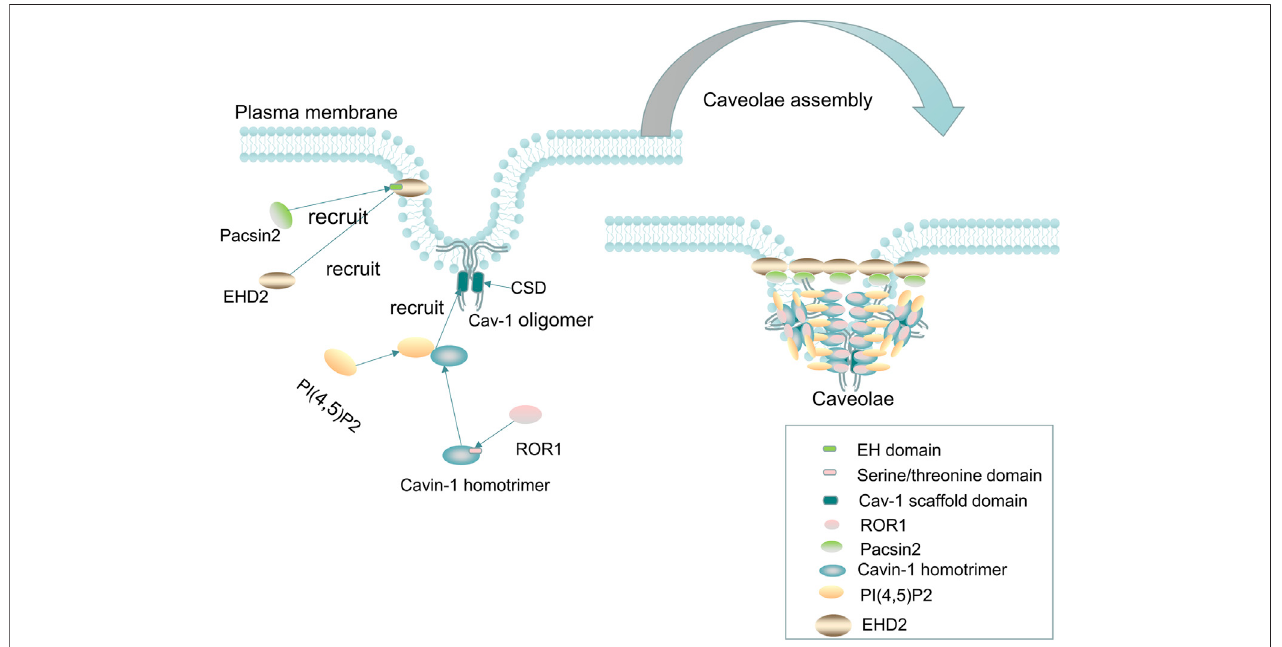
FIGURE 1 | Cav-1 and caveolae. Cav-1 is essential for the formation of caveolae. The cholesterol-containing scaffold protein domain (CSD) of Cav-1 binds to cholesterol on the plasma membrane, and then, the Cavin-1 complex, EHD2, PACSIN2, and ROR1 are recruited to form mature caveolae. The recruited cavin-1 fi rst binds to lipids [such as phosphatidylserine, and PI(4,5)P2] and then binds to the cholesterol-containing scaffold protein domain of Cav-1 to stabilize the curvature of the membrane. Two-thirds of the kinase domain of ROR1, as the scaffold protein of cavin-1 and Cav-1, binds to cavin-1, thereby promoting the binding of Cav-1 and preventingautophagydegradationofCav-1.Inaddition,EHD2isrecruitedtotheneckofcaveolaetoformaloopthrougholigomerization,andthen,Pacsin2bindstothe EH domain of EHD2 to maintain the stability of Caveolae and the distribution of Cav-1 on the plasma membrane. Without EHD2, the stability of caveolae and the distribution of Cav-1 on the plasma membrane will be dif fi cult to maintain, resulting in dissociation of the caveolae from the plasma